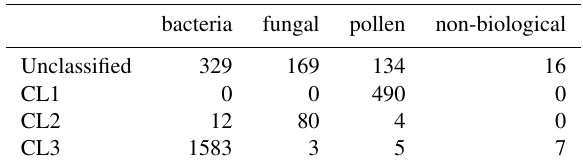
Table 8. Matching matrix for the best case scenario when using DBSCAN with 9 σ , (cid:15) = 0 . 4 and a minimum number of points of 0.7% on the 2014